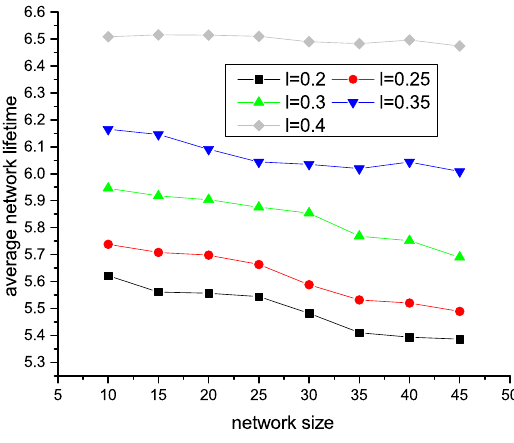
Figure 7. Effect of parameter l in centralized HAS 4 on network lifetime.